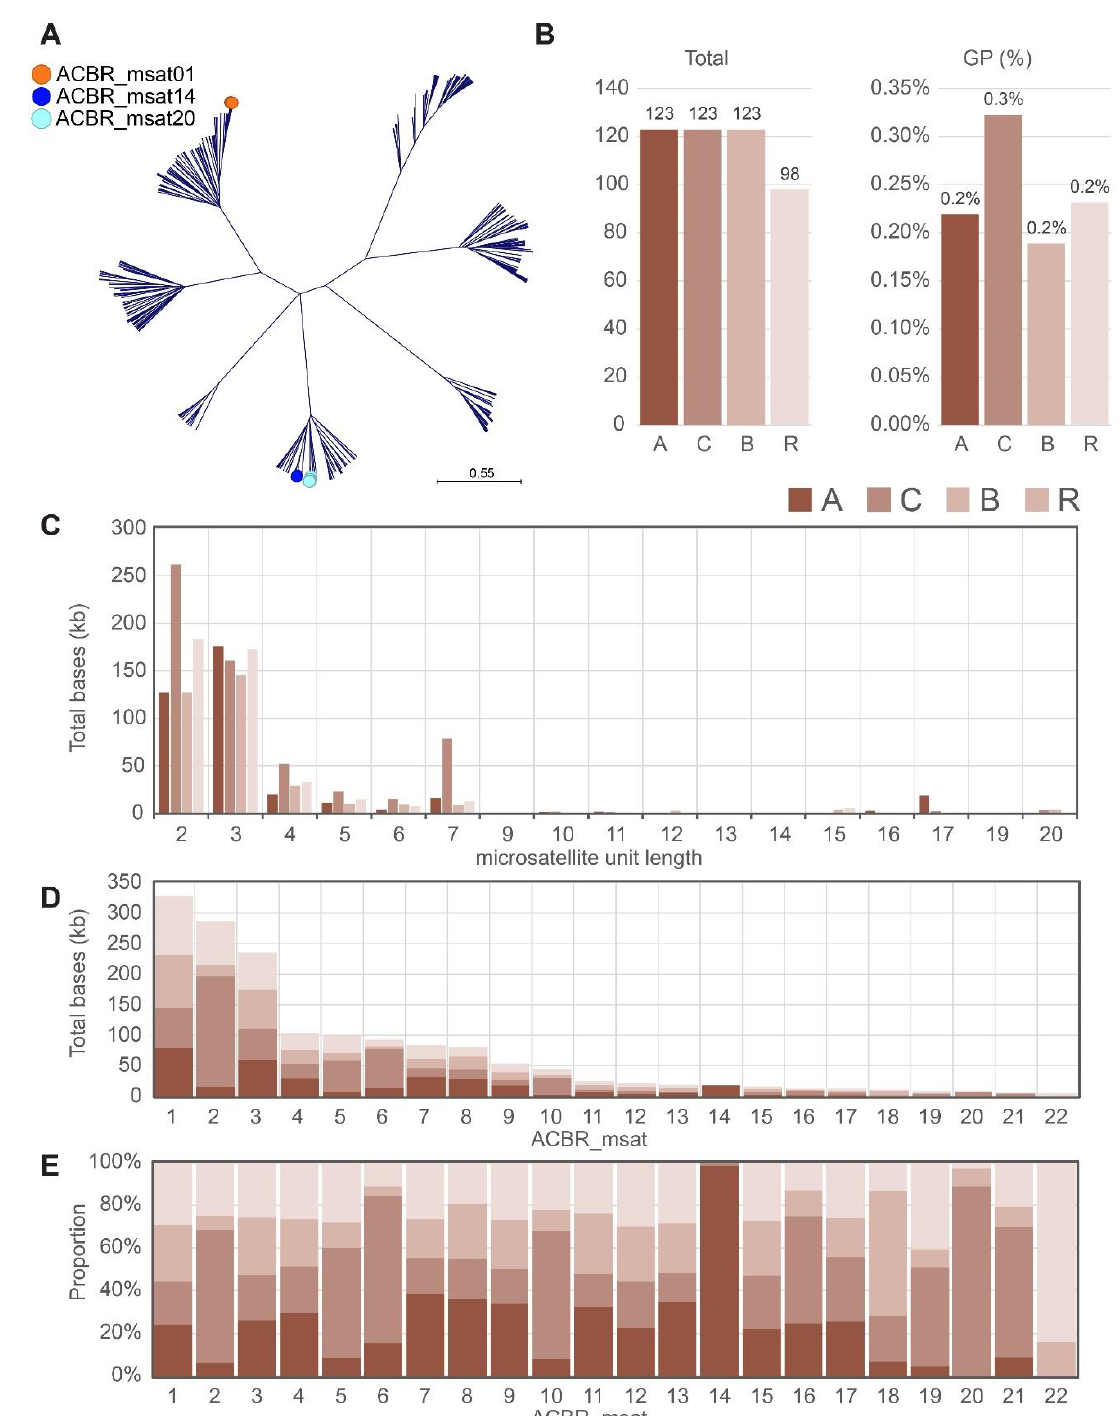
Figure 1. Quantification of microsatellites in the A, C, B, and R genomes. ( A ) Clustering of 467 microsatellites that were ≤ 20 bp in the A, B, C, and R genomes. The three microsatellites that showed genome-specific distribution are shown in circles. ( B ) Distribution of the 467 microsatellites by genome in terms of total counts and genome proportions (GP). ( C ) Abundance of microsatellites according to monomer length. ( D ) Cumulative base count of the 22 microsatellites that had a cumulative base count of ≥ 6 kb. The numbers in the x -axis correspond to the microsatellite names listed in Table 3. ( E ) Cumulative proportion of each microsatellite in the A, C, B, and R genomes. Note the predominant abundance of ACBR_msat14 and ACBR_msat20 in the A and C genomes, respectively. ACBR_msat01 showed relative equal abundance in the four genomes. Bar graph colors in C – E are same as those in B.